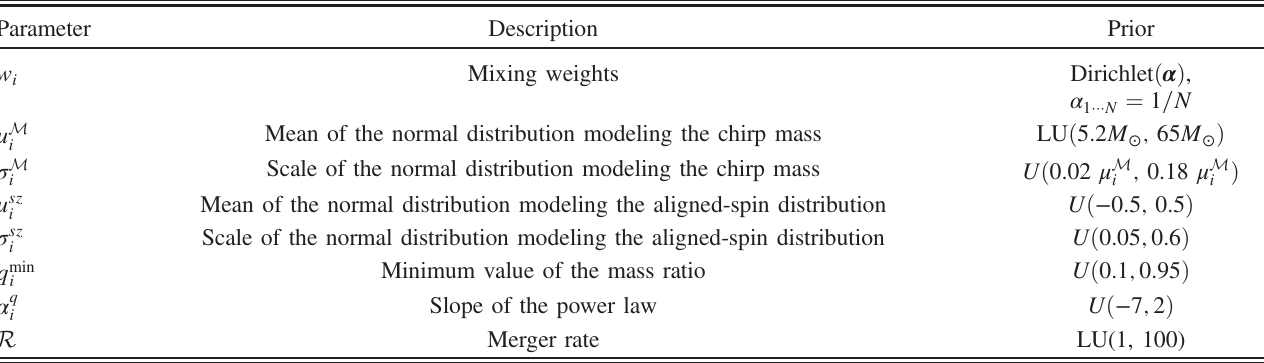
TABLE VIII. Summary of F LEXIBLE MIXTURES model parameters. All rates are in Gpc − 3 yr − 1 .